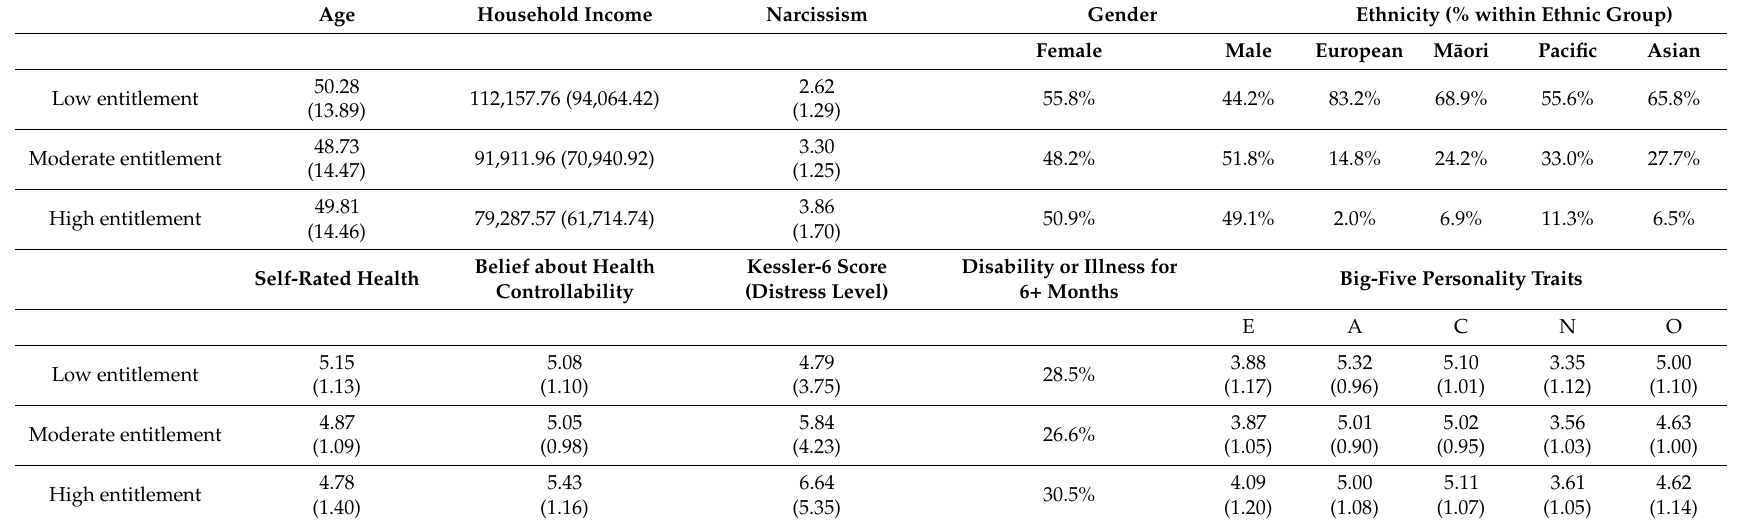
Table A2. Demographic and psychological characteristics of low, moderate, and high entitlement